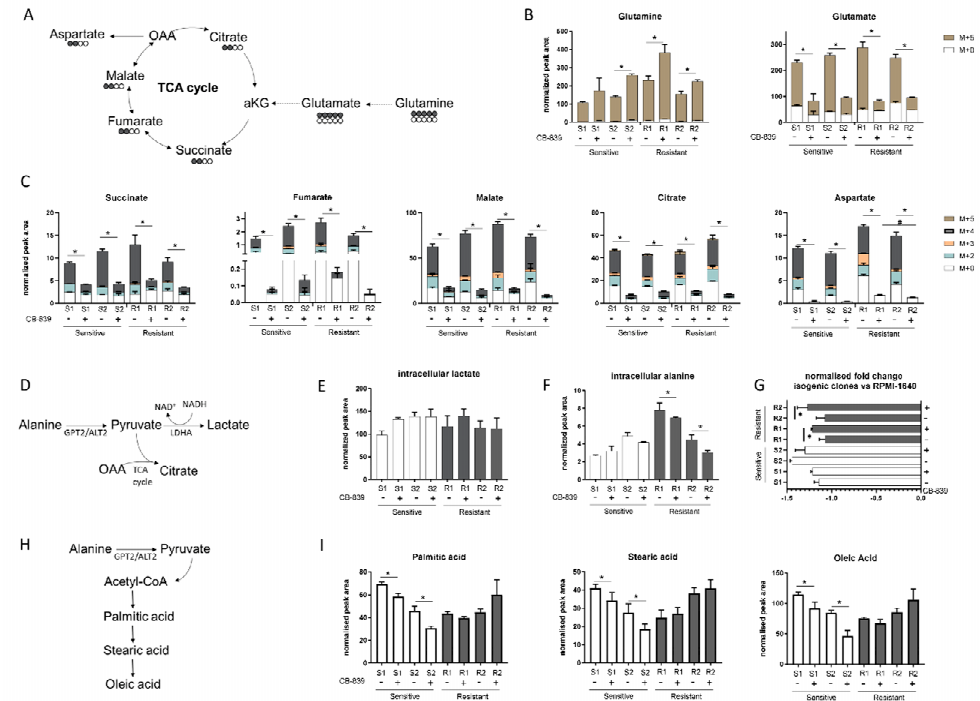
Figure 2. ( A ) Schematic representation of the 13-C glutamine labelling experiment. ( B ) M + 0 and M + 5 glutamine and glutamate abundance in two sensitive and two resistant H1299-derived clones with or without CB-839 (500 nM, 24 h treatment). ( C ) Isotope labelling of the TCA cycle in the presence of 13C 5 -glutamine with or without CB-839 (500 nM, 24 h treatment) in two sensitive (S1, KRASwt / LKB1wt, S2, KRASmut / LKB1wt) and two resistant (R1, KRASwt / LKB1del, R2, KRASmut / LKB1del) H1299-derived clones (normalized peak area). ( D ) Schematic representation of intracellular pyruvate metabolism. ( E ) Intracellular lactate levels (normalized peak area) with or without CB-839 (500 nM, 24 h treatment) in two sensitive and two resistant H1299-derived clones. ( F ) Intracellular alanine levels (normalized peak area) with or without CB-839 (500 nM, 24 h treatment) in two sensitive and two resistant H1299-derived clones. ( G ) Normalized fold change of extracellular alanine levels vs. unconditioned RPMI-1640 with or without CB-839 (500 nM, 24 h treatment) in two sensitive and two resistant H1299-derived clones. ( H ) Schematic representation of fatty acid biosynthesis. ( I ) Intracellular levels of fatty acids with or without CB-839 (500 nM, 24 h treatment) in two sensitive and two resistant H1299-derived clones. Mean ± SD of triplicate culture / conditions. Statistical significance * p < 0.05 untreated vs CB-839 treated cells, # p < 0.05 untreated sensitive vs untreated resistant cells, Wilcoxon Mann–Whitney test (M + 0, M + 2, M + 3, M + 4, M +